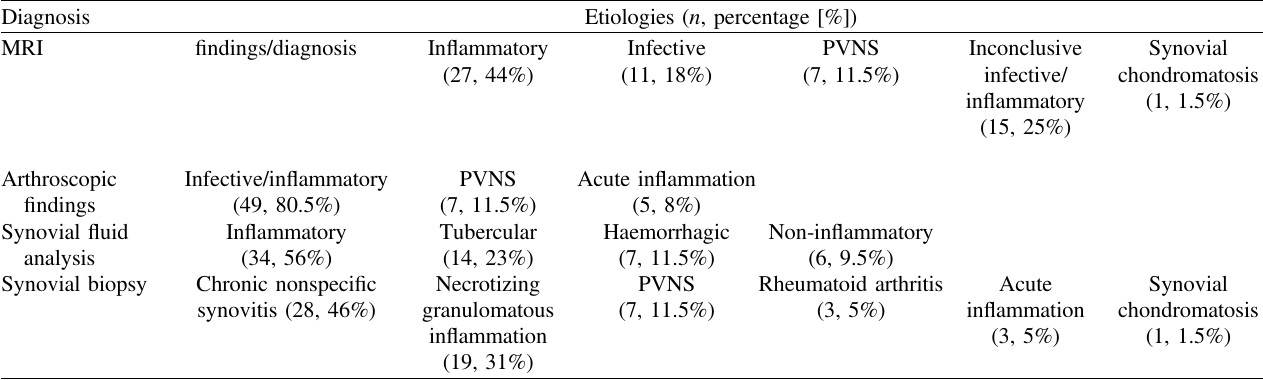
Table 2. Tabulation of diagnosis by MRI, arthroscopy, synovial fl uid analysis, and synovial biopsy: results expressed as the number of cases